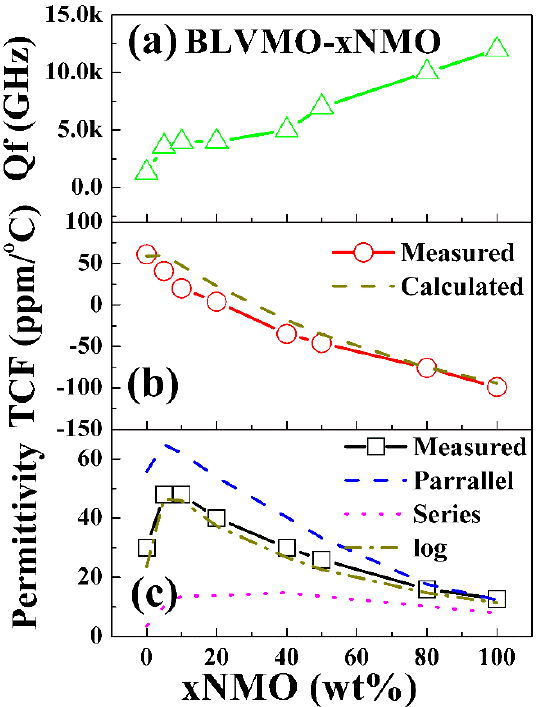
Figure 5. The microwave properties of (100 − x) wt.% BLVMO-x wt.% NMO ceramic composites as a function of x (NMO fraction). ( a ) Qf , ( b ) TCF, ( c ) ε r .